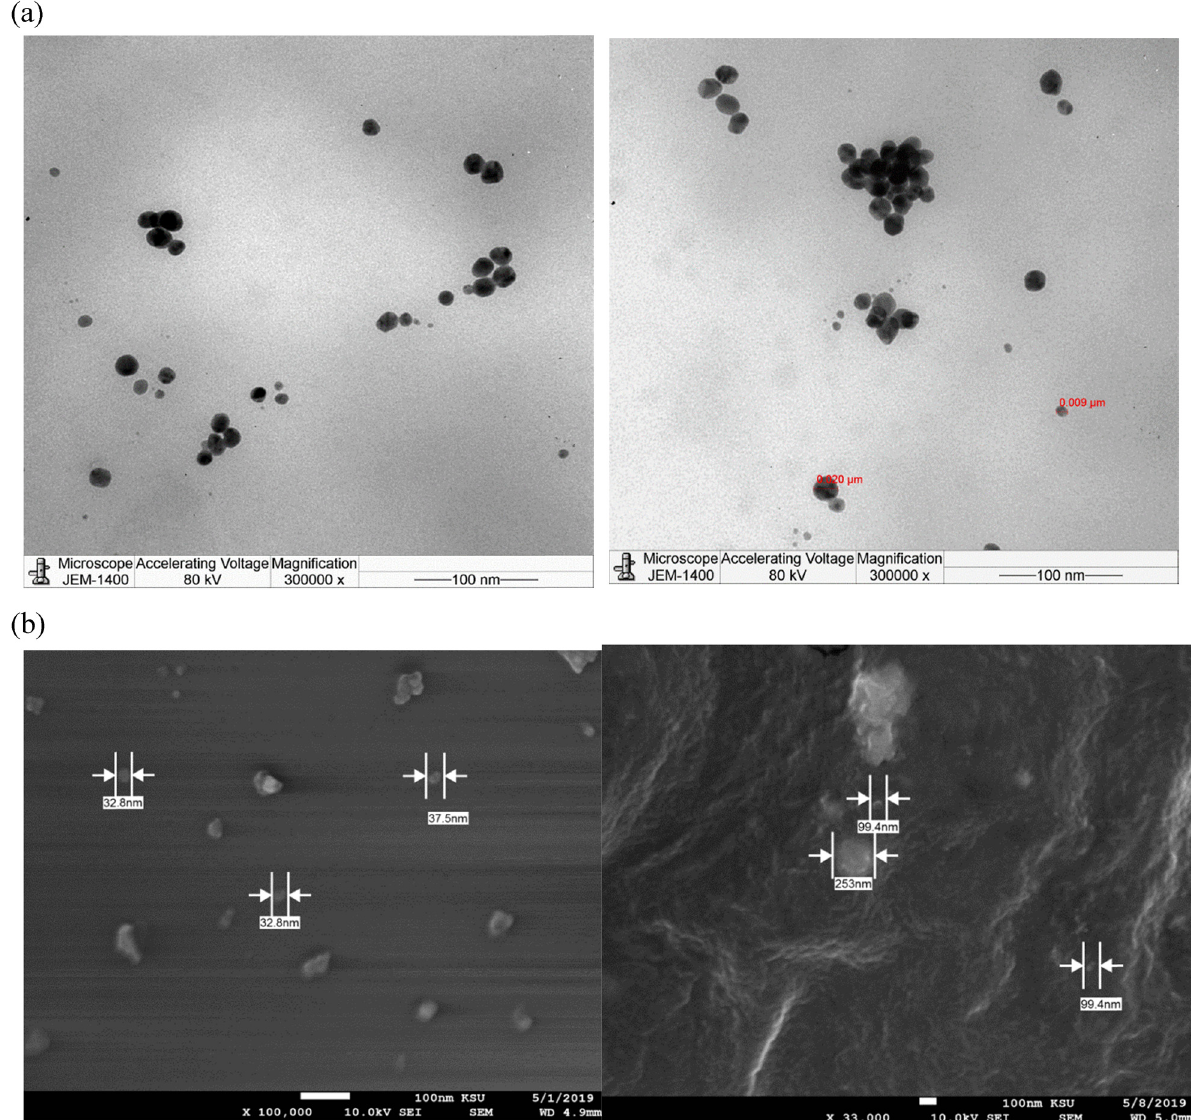
Figure 4: ( a ) TEM micrograph and ( b ) SEM micrograph of the green - synthesized A. digitata